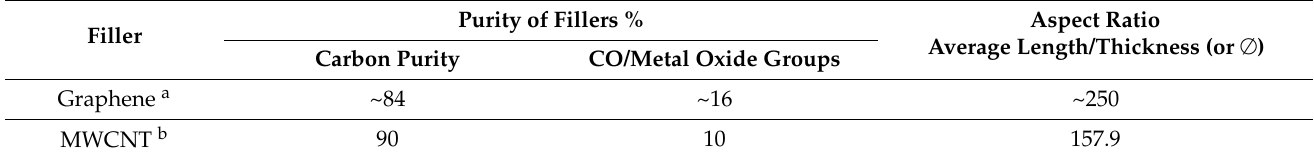
Table 2. Comparison between graphene and multi-walled carbon nanotube